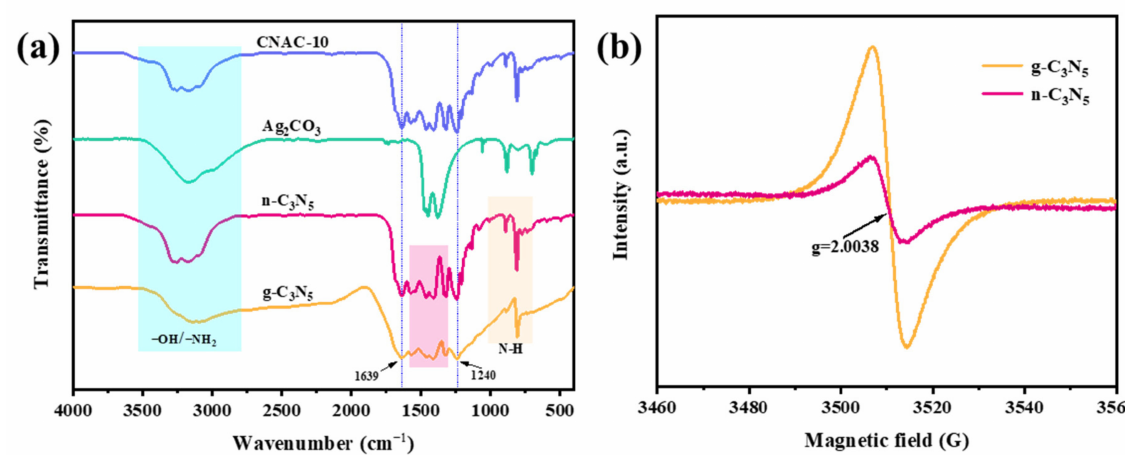
Figure 4. ( a ) The FTIR spectra of g-C 3 N 5 , n-C 3 N 5 , Ag 2 CO 3 , and CNAC-10; ( b ) the EPR spectra of g-C 3 N 5 and n-C 3 N 5